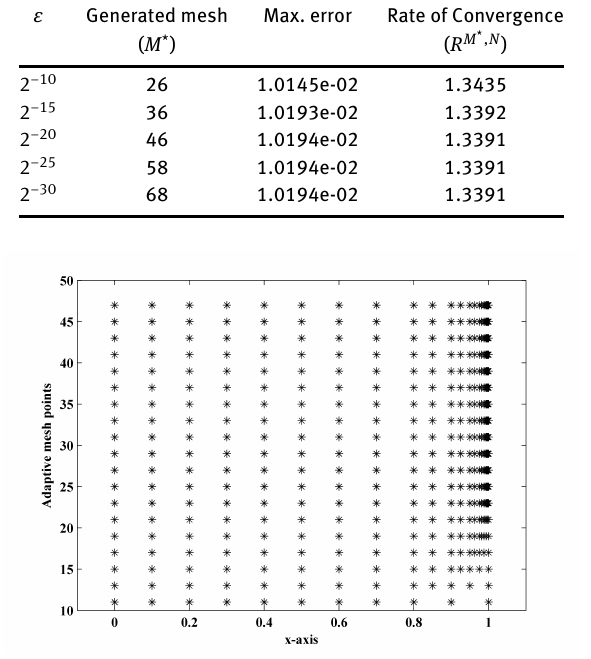
Fig. 4: Adaptive mesh generation for example 5.2 with ε = 2 −20 , δ = 0 , η = 0.5 , M=10(initially) and N=20.